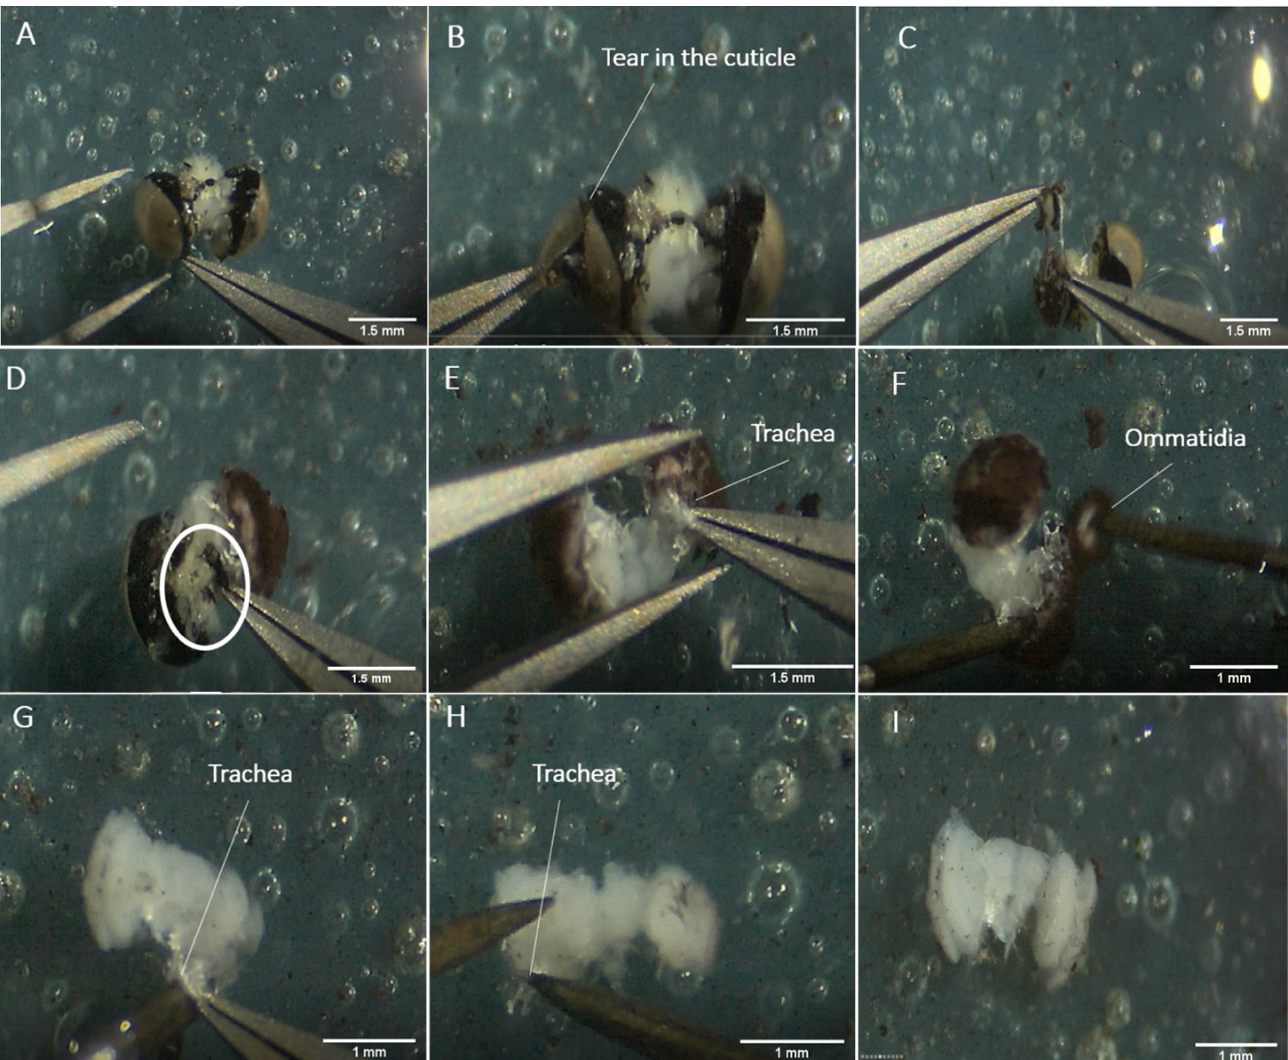
Figure 4. Dissection of an adult brain. ( A ) A small part of the brain is grabbed to submerge it fully in HBS. ( B ) While the brain is submerged, a superficial tear in the cuticle of one eye is made. ( C ) A small piece of cuticle is removed on the side of the eye. ( D ) The non-brain tissue that is loosely attached to the back of the brain is removed, as indicated by the white circle. ( E ) The cuticle of both eyes is removed, exposing some trachea. The trachea is the white, stringy, and sticky substance attached to the brain tissues. It is important to control the pulling force so that the brain tissues are not accidentally teared. ( F ) The ommatidia are packed together into a reddish-brown spongy tissue, and this is removed from one side of the eye. ( G ) Some trachea still attached is pulled away with curved forceps. ( H ) The remaining trachea can also be scraped away with insect pins. ( I ) The fully dissected brain can be used for further analyses.